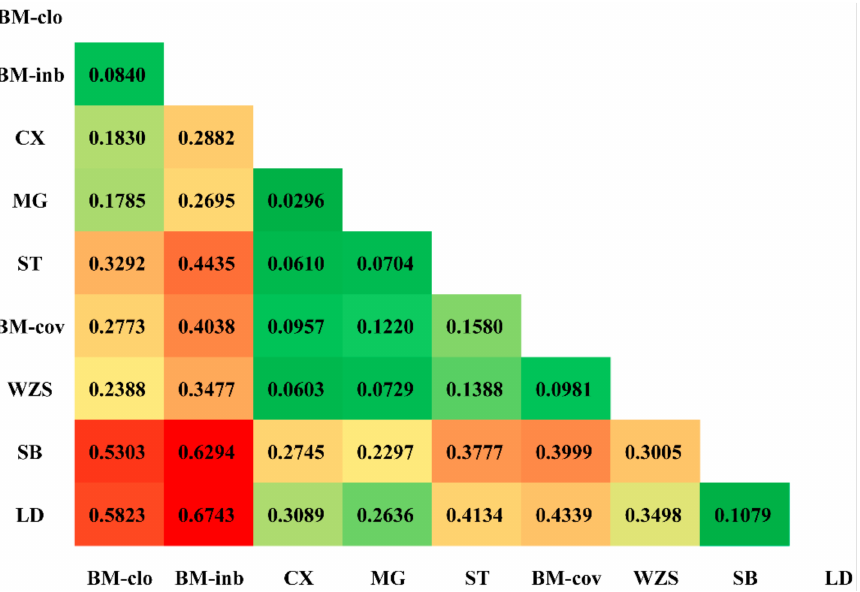
Figure 3. Heatmap of the fixation indices (F ST ) between miniature pigs. The higher F ST estimated is in red, the lower F ST estimated is in